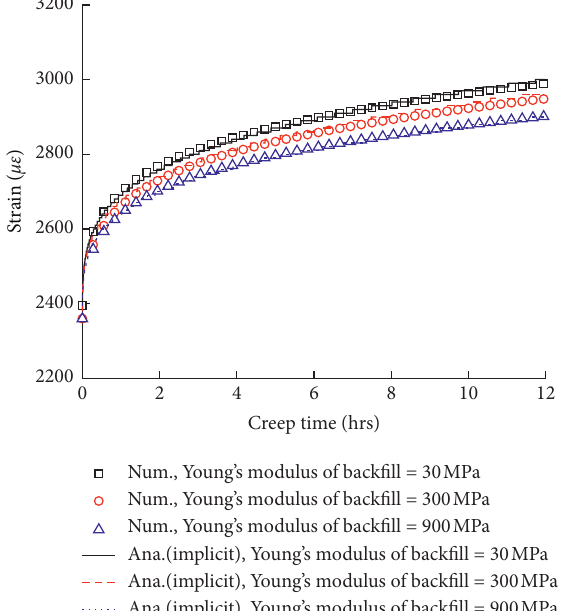
Figure 7: Comparison of viscoelastic theoretical solution and numerical simulation of infinite circular hole in backfill